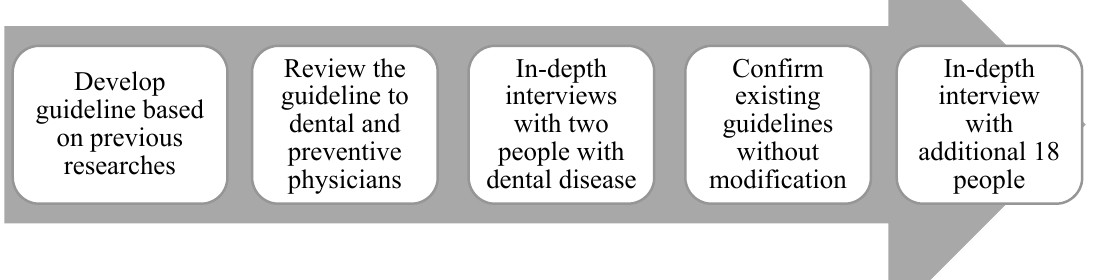
Figure 1. In-depth interview paradigm. Int. J. Environ. Res. Public Health 2020 , 17 , x